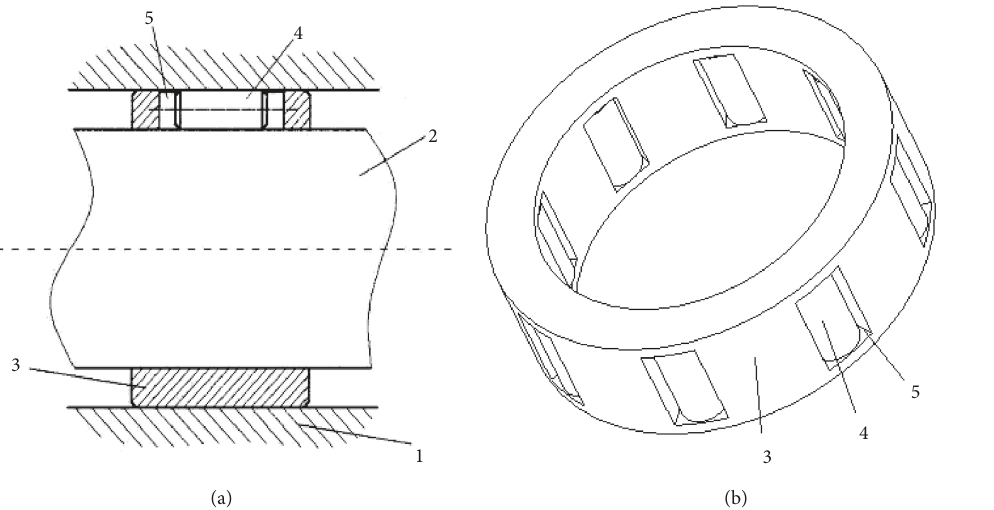
Figure 1: Structural diagram of the bearing with the floating sleeve. The numbered parts are as follows:1: bushing, 2: shaft journal, 3: floating sleeve, 4: roller, and 5: roller